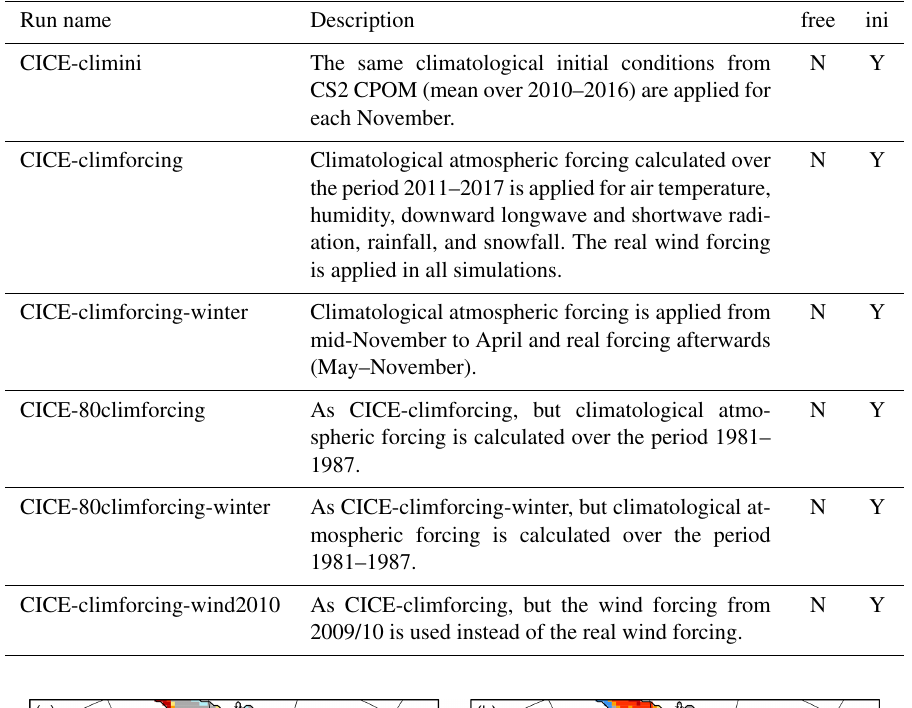
Table 3. Sensitivity simulations exploring the impact of initial and forcing conditions. “Free” indicates multi-year simulations from 1980 to 2017; “ini” indicates seven 1-year-long simulations starting in mid-November with CS2 sea ice thickness (2010/11 to 2016/17). The model configuration for all simulations is CICE-best.